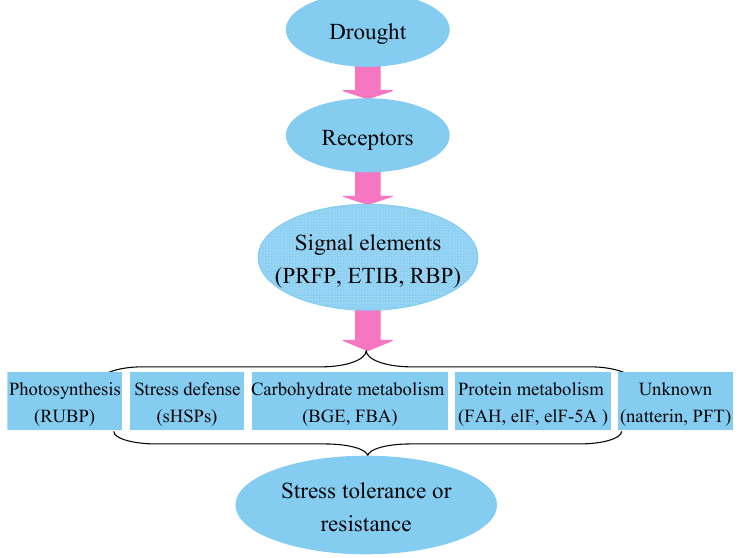
Figure 6. Schematic model of the action of water deficiency stress modified from Huang and colleagues [27]. The figure between brackets indicated the regulated protein species identified in the present study. BGE, β - D -glucan exohydrolase; eIF, translation elongation/ initiation factor family protein; eIF-5A, eukaryotic translation initiation factor 5A; ETIB, electron carrier/electron transporter iron ion binding protein; FAH, fumarylacetoacetate hydrolase domain-containing protein 1; FBA, fructose-bisphosphate aldolase; sHSPs, small heat shock proteins include 16.9 and 17.4 kDa; PFT, pore-forming toxin-like protein Hfr-2; PRFP, WD40-like beta propeller repeat family protein; RBP, RNA-binding protein FUS-like isoform X2; RUBP, ribulose-1,5-bisphosphate carboxylase/oxygenase or ribulose bisphosphate carboxylase/oxygenase